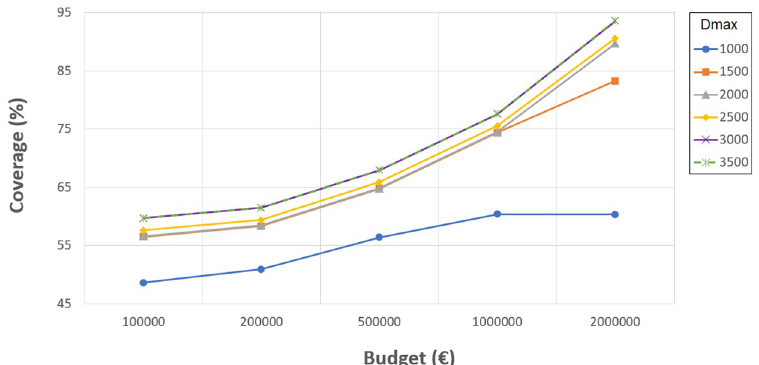
Fig 11. Coverages for the different distances and budgets in 2030 while expanding the primary schools in